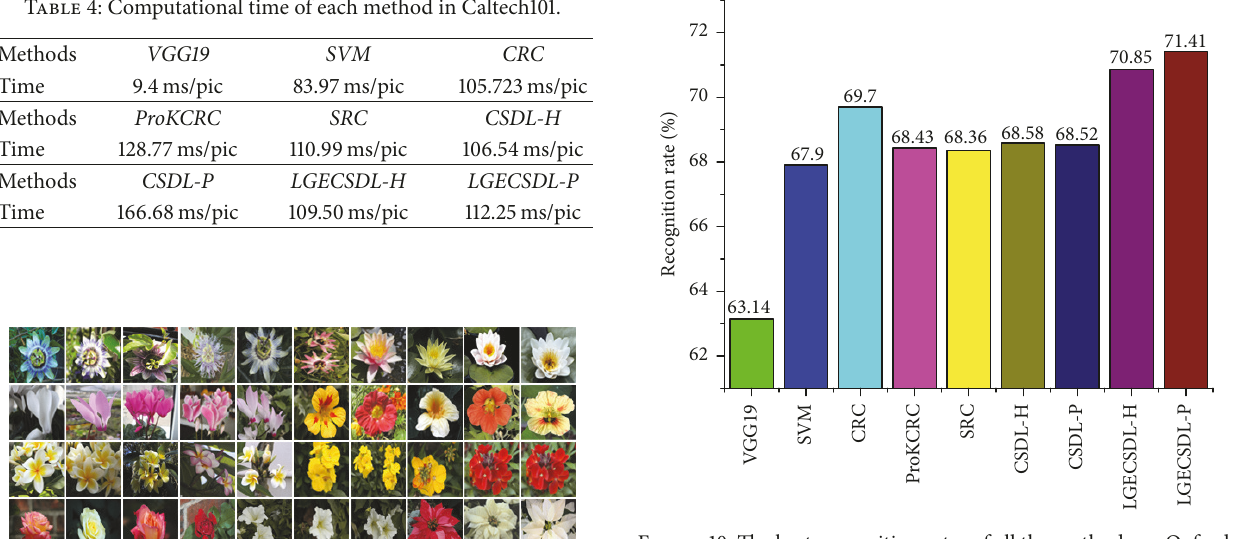
Figure 10: The best recognition rates of all the methods on Oxford-